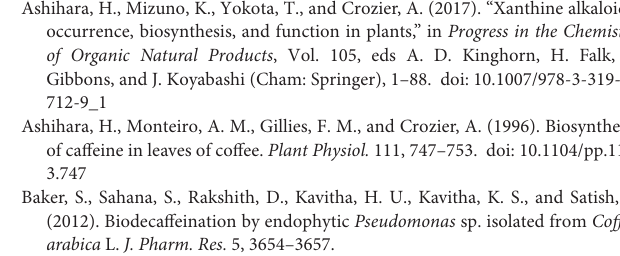
Supplementary Table 4 | Arrangement of gene